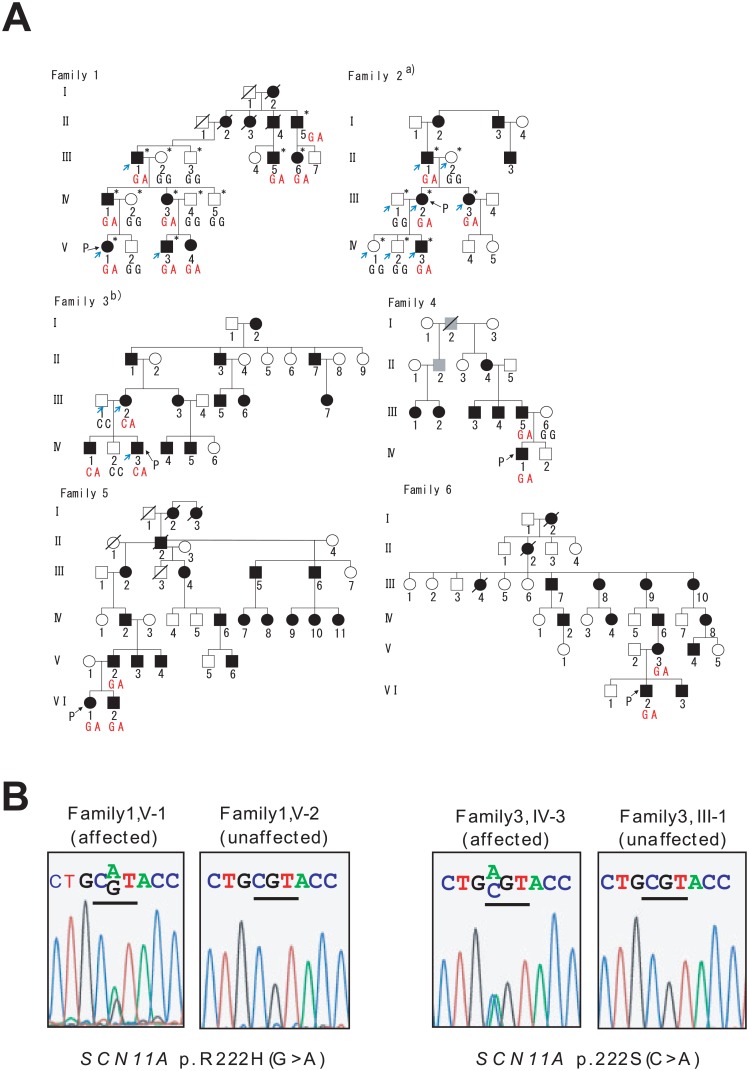
Pedigrees of six Japanese familial episodic pain syndrome in Japanese families.(A) Some a)Family 2 and b)Family 3 members have been reported previously [13, 14]. Black and white symbols indicate affected and unaffected individuals, respectively. Gray symbols indicate individuals with unknown phenotypic status. Squares and circles indicate males and females, respectively. Slashes indicate deceased individuals. “P” indicates probands. Blue arrows indicate exome sequenced individuals. * indicates linkage analysis performed individuals. The genotype of SCN11A p.R222H (Family 1, 2, 4, 5 and 6) or SCN11A p.R222S (Family 3) for each individual is illustrated. (B) Sequence chromatography of the identified SCN11A mutations.